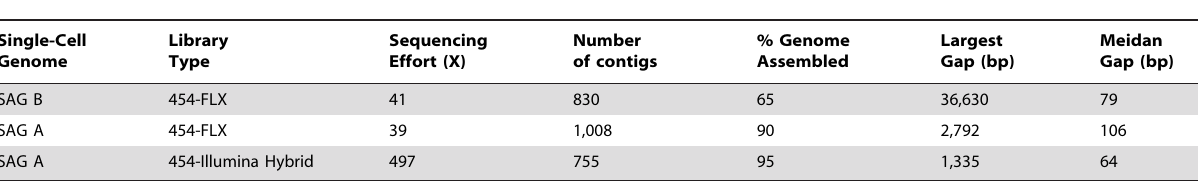
Table 1. De novo assembly statistics of single-cell amplified genomes.